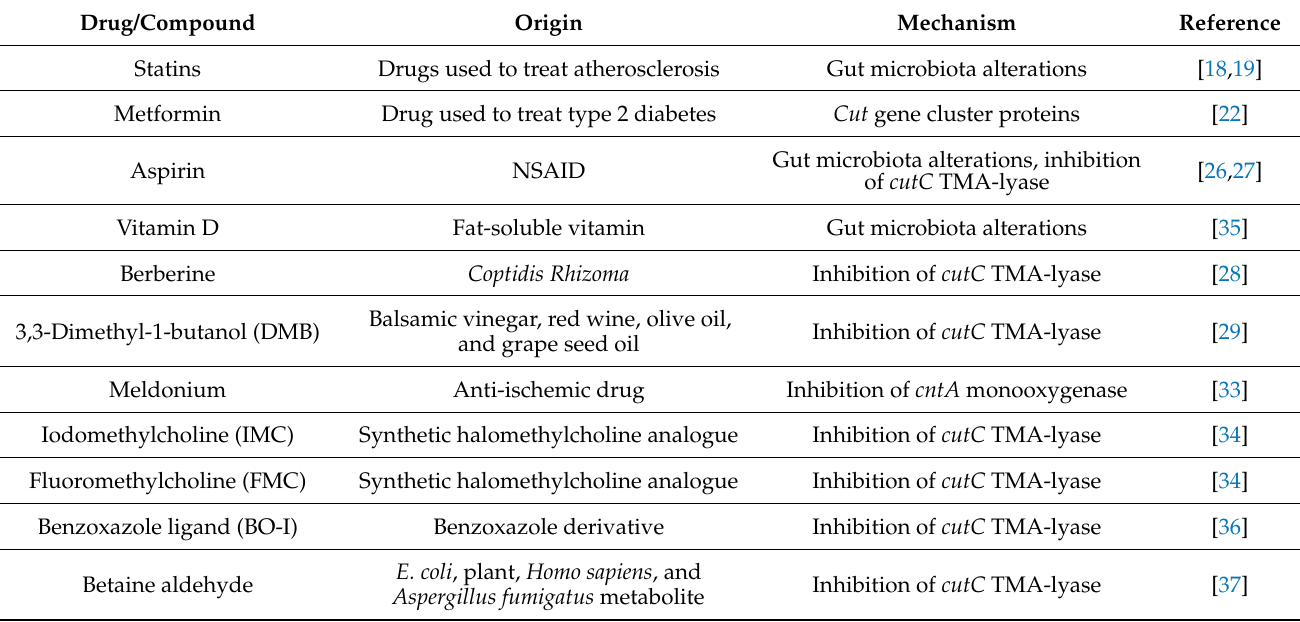
Table 2. Drugs/compounds, and their origins and mechanisms, that reduce TMAO